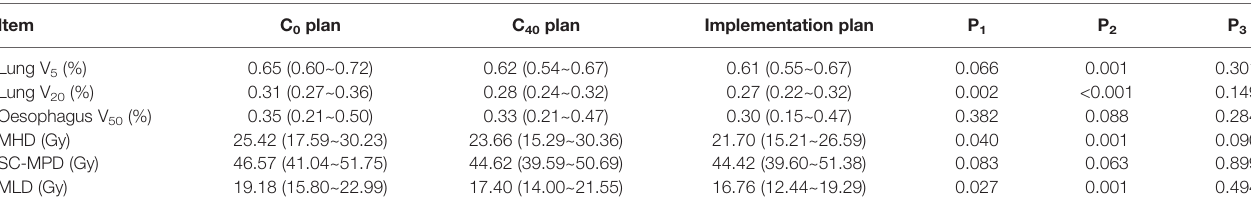
TABLE 4 | Comparison of dose-volume histogram parameters in the pre-treatment localization (C 0 ) and 40 days post-treatment (C 40 ) simulation plans and implementation plans in 21 patients (mean and range).